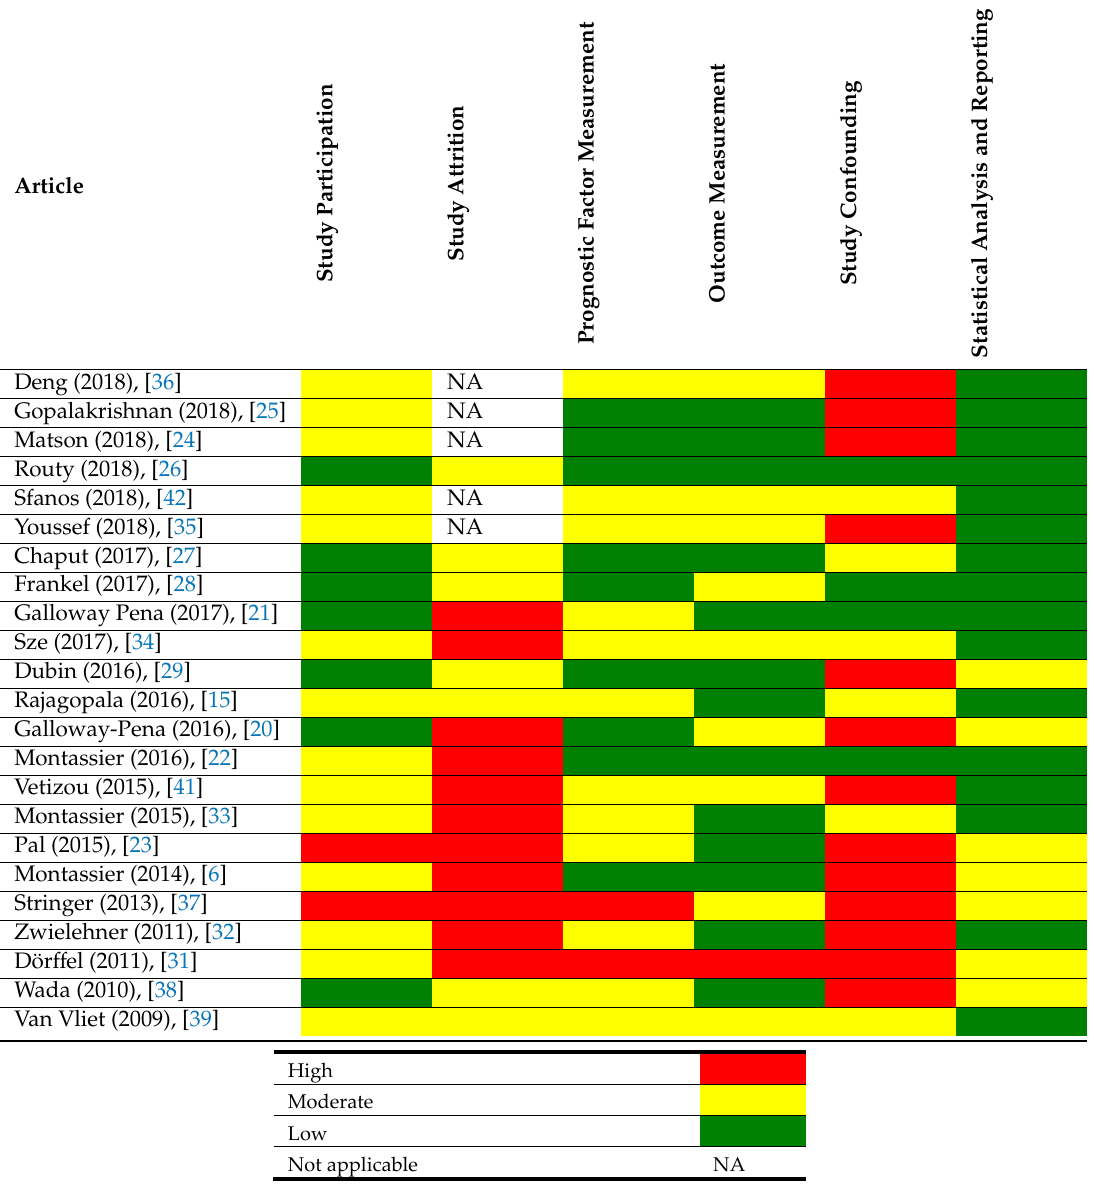
Table A1: Risk of bias of included studies assessed by Quality in Prognosis Studies tool (QUIPS).